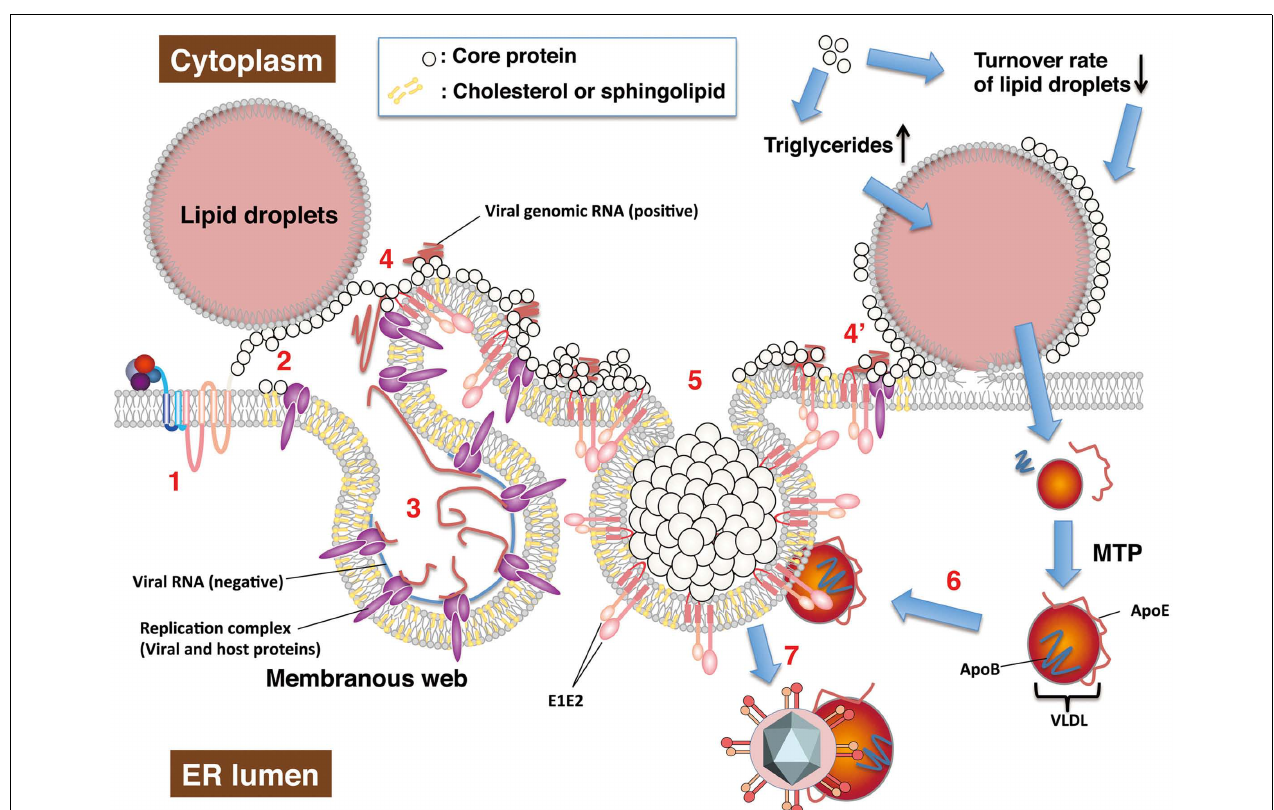
synthesized by the replication complex based on each other. (4)The positive strand of genomic RNA is enclosed with the core proteins, cooperating non-structural proteins. Envelope proteins, NS2, and p7 may determine recruitment of the core protein from lipid droplets to the ER membrane along microtubules. Lipid droplets hemi-fused with ER membrane (Wolins et al., 2006) may be involved in recruitment of core protein on the ER membrane (4 (cid:2) ). (5)The core proteins enclose the viral RNA genome, and are then surrounded by envelopes. Non-structural proteins and other factors may support formation of nucleocapsid and budding. (6)VLDL binds to viral particles to form LVP before or after budding. (7)The viral particles egress into the ER lumen withVLDL including ApoE.The core protein upregulates synthesis or storage of triglycerides and cholesteryl ester, cooperating